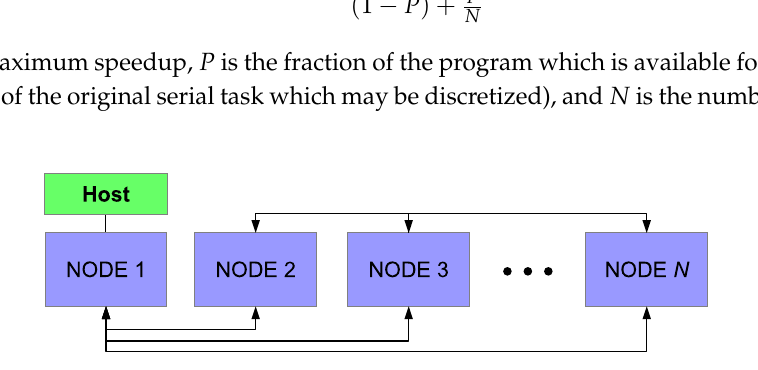
Figure 12. Communication between host and nodes within the MPI architecture.